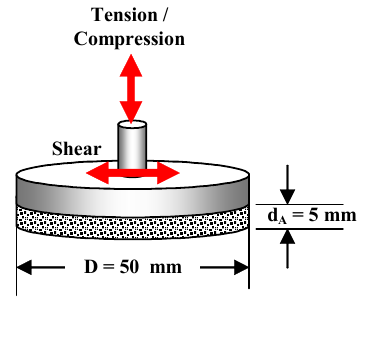
Figure 1: Point support geometry. Figure 2: Photograph of point support specimen.